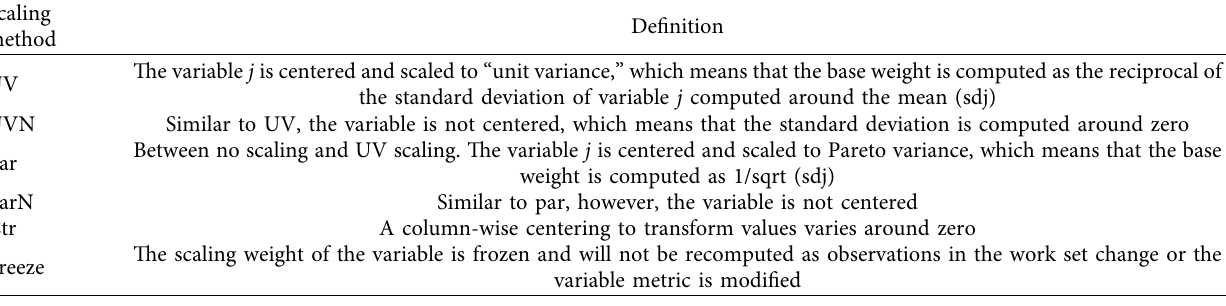
Table 1: Definition of six scaling methods.